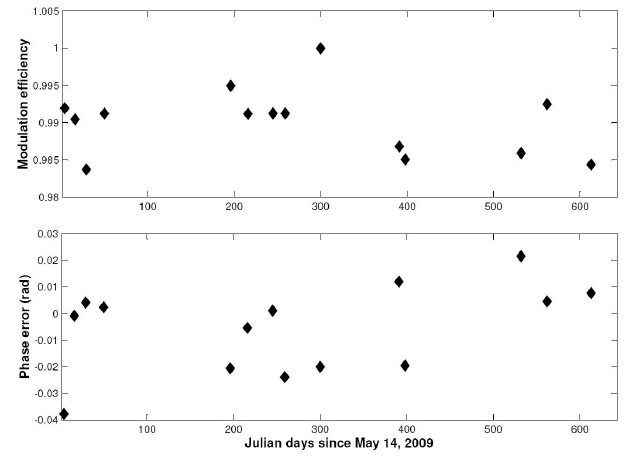
Fig. 1. Evolution of the ILS during the measurement